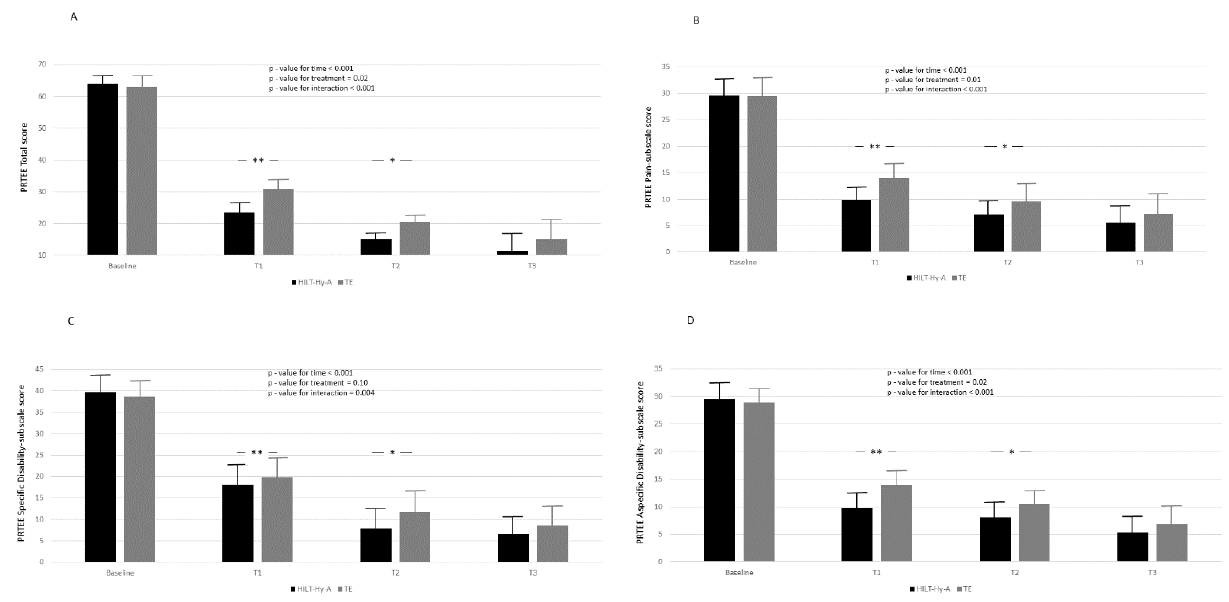
Figure 3. Report the PRTEE total score ( A ), the pain subscale score ( B ), the specific disabil-ity score ( C ), and the usual activity score ( D ). according to time and treatment; black box represents high- intensity laser therapy plus hyaluronic acid (HILT + Hy-A) group, whereas grey box represents therapeutic exercise (TE). Results for linear mixed model analysis (p-value for time, treatment, and interaction of time for reatment). Bonferroni adjustment for multiple comparisons applied between follow-ups of the study compared to baseline; *: p < 0.05, **: p < 0.001 .